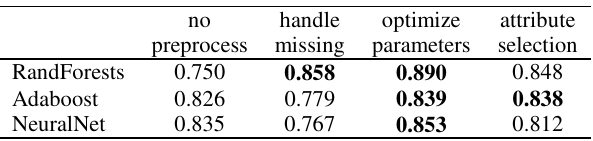
Table 3: Improvement of AUC by preprocessing, for selected